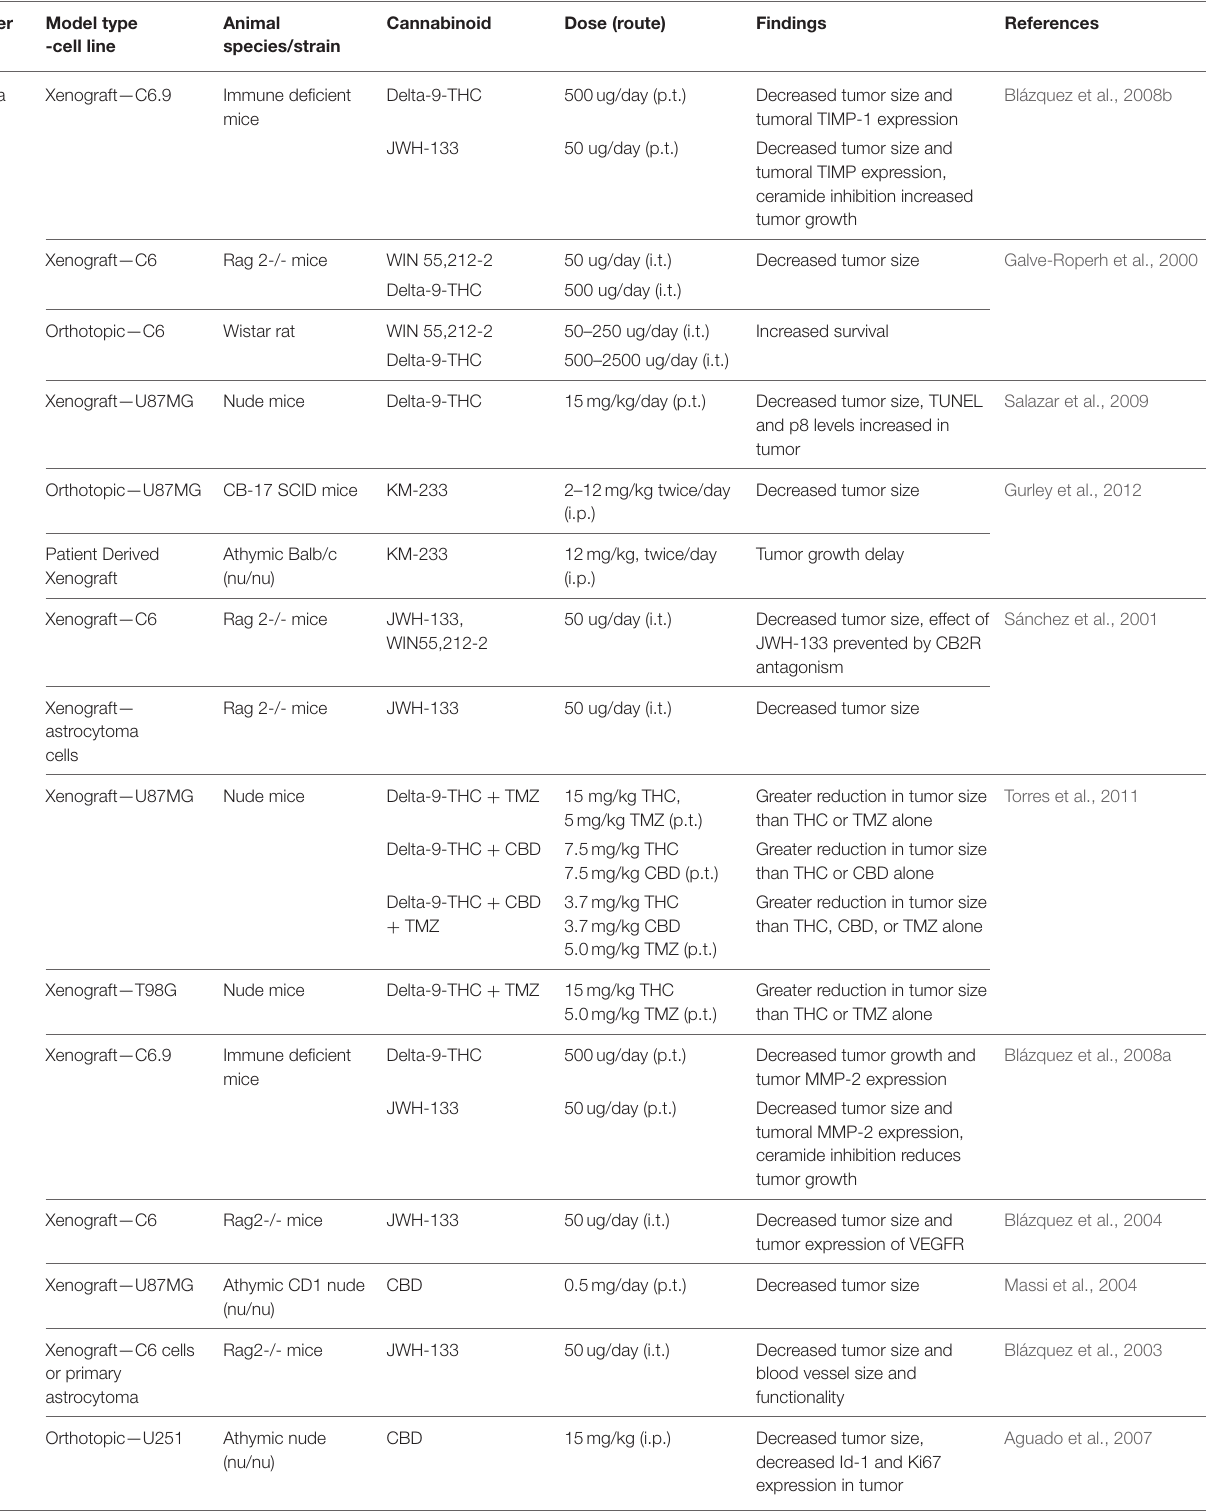
TABLE 1 | Pre-clinical assessment of cannabinoids on tumor